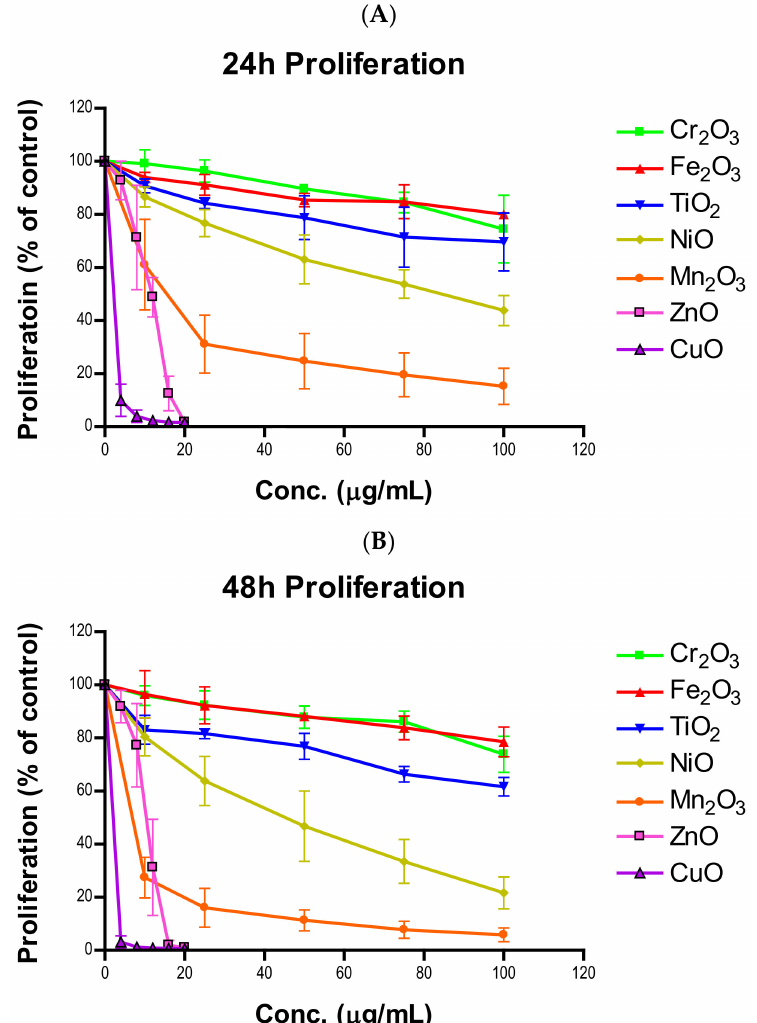
Figure 4. Proliferation of A549 cells after ( A ) 24-h or ( B ) 48-h exposure to various concentrations of one of seven